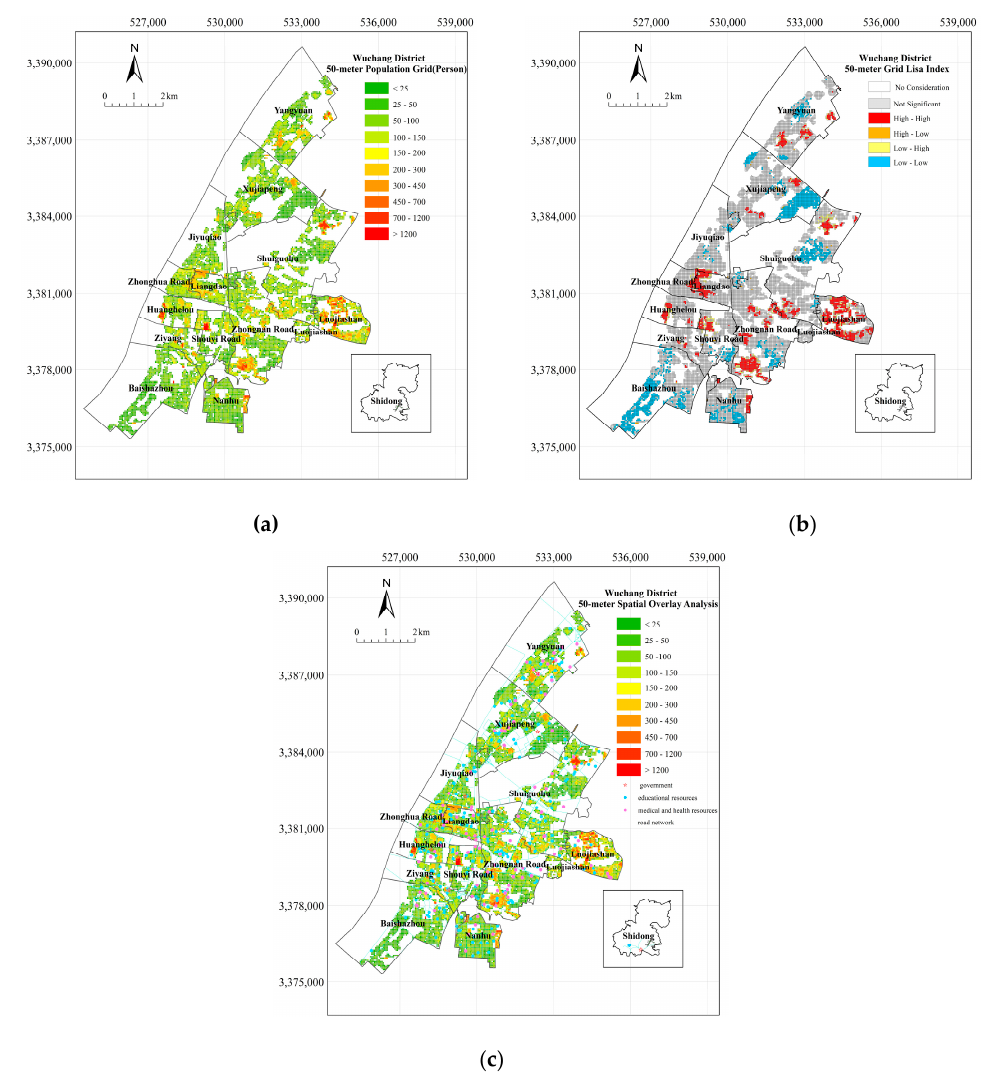
Figure 10. The Experimental Results and Analysis on the Street Level (( a ) Wuchang 50-m Population Grid; ( b ) The Result of Local Moran’s I; and,( c ) Spatial Overlay Analysis).